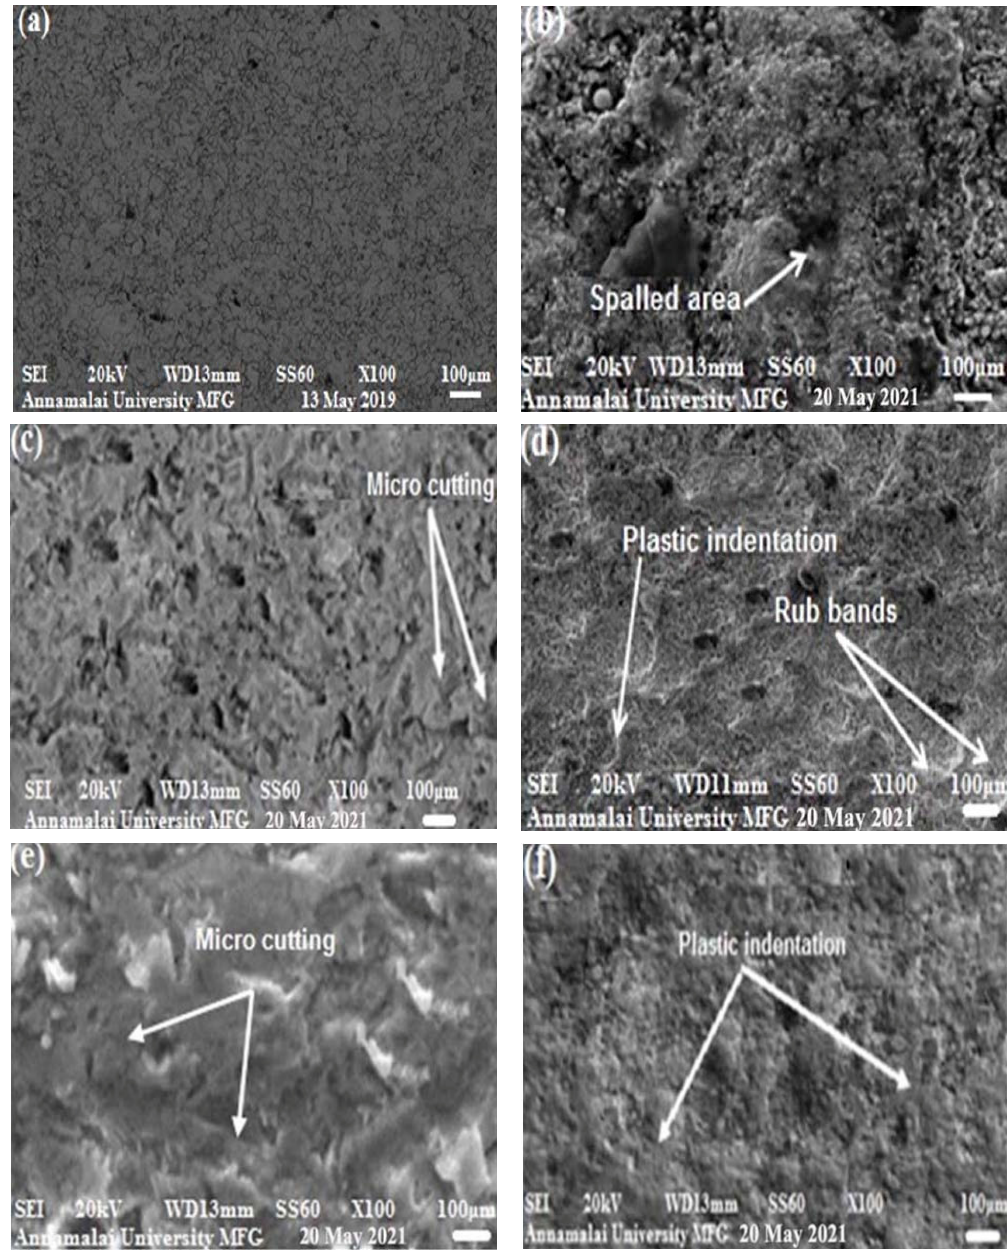
Figure 8. Worn surfaces of the coatings and substrate at different standoff distances: ( a , c , e ) uncoated substrate; ( b , d , f ) coatings.